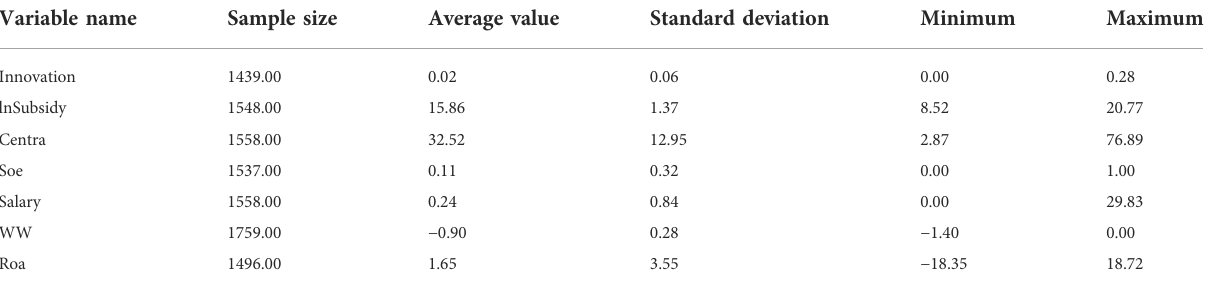
TABLE 3 Descriptive statistics of